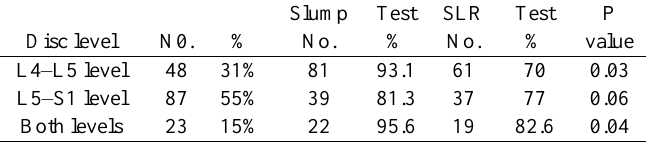
Table 1: Disc herniation level by MRI and Physical tests